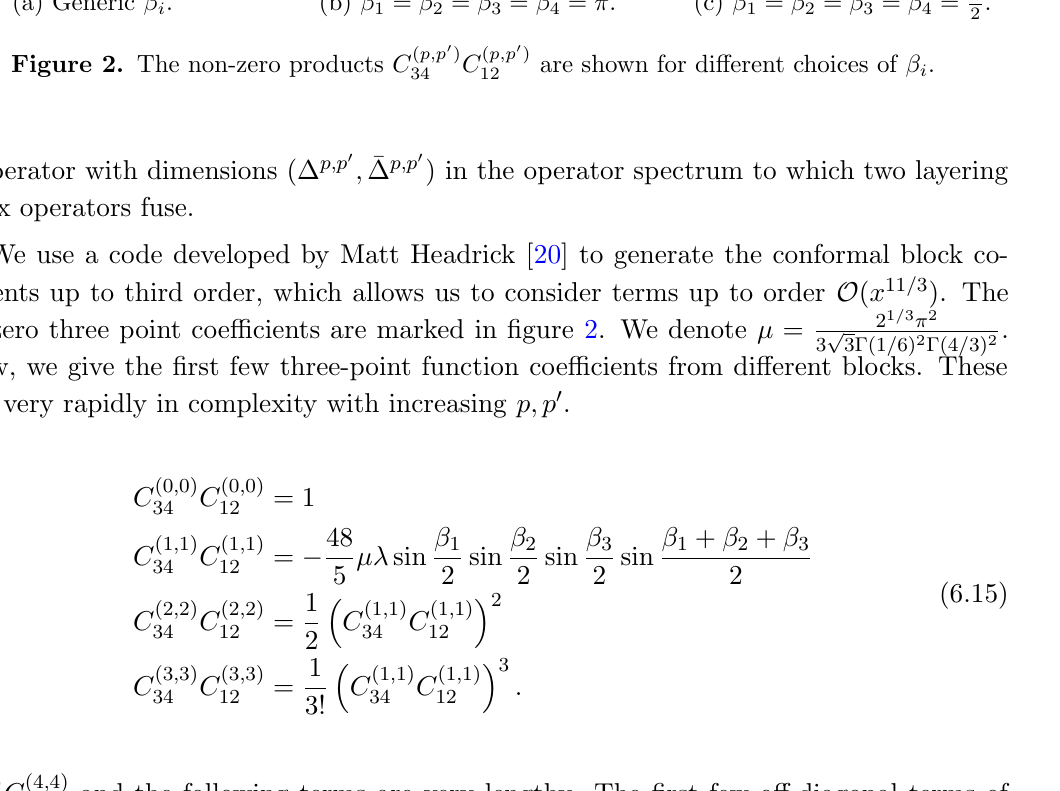
(c) (cid:12) 1 = (cid:12) 2 = (cid:12) 3 = (cid:12) 4 = (cid:25)